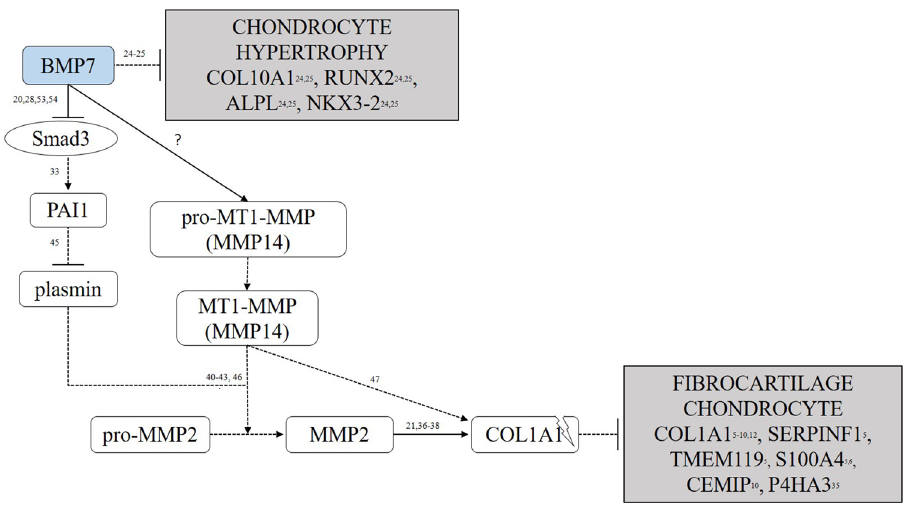
Figure 4. Proposed molecular interactions by which BMP7 attenuates the fibrocartilage chondrocyte phenotype. The potential molecular pathway by which BMP7 attenuates the fibrocartilage chondrocyte phenotype as proposed in this study. Upon BMP7 exposure, chondrocytic cells demonstrate reduced SMAD3 signaling, interfering with PAI1 expression and activity. In addition, following BMP7 exposure, MMP2 expression and activity is increased via PAI1 and MT1-MMP, resulting in a reduced fibrocartilage chondrocyte phenotype. BMP7’s mode of action to reduce chondrocyte fibrosis is MMP2-dependent. Dashed lines: interactions which have been found in organ-fibrosis (with corresponding references), but have not been demonstrated directly in the present study. Solid lines: interactions directly demonstrated in the present study (regarding chondrocyte